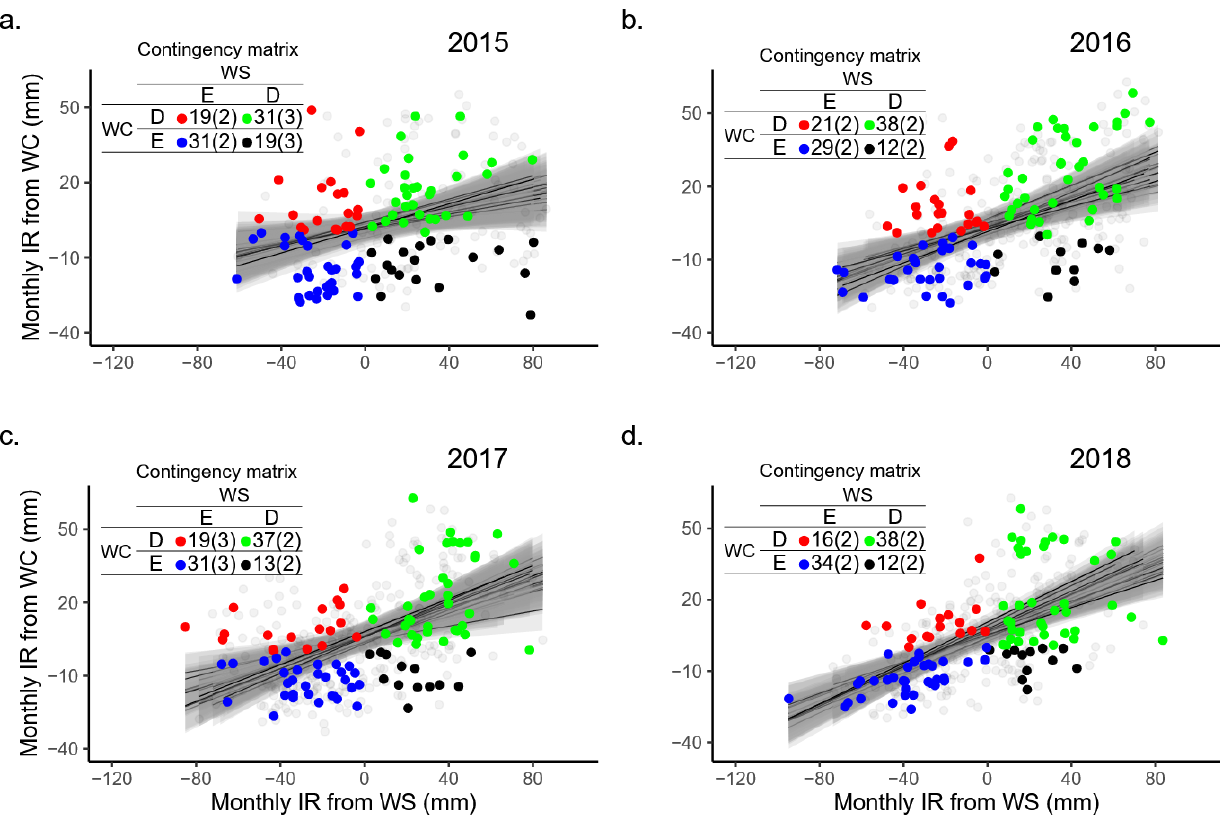
Figure 3. Validation of monthly IR from WorldClim (WC) using Weather Stations (WS) data from: ( a ) year 2015; ( b ) year 2016; ( c ) year 2017; and ( d ) year 2018. Colored points represent one of the coincident subsamples with the average contingency matrix (in parenthesis standard deviation). Gray points represent other subsamples.